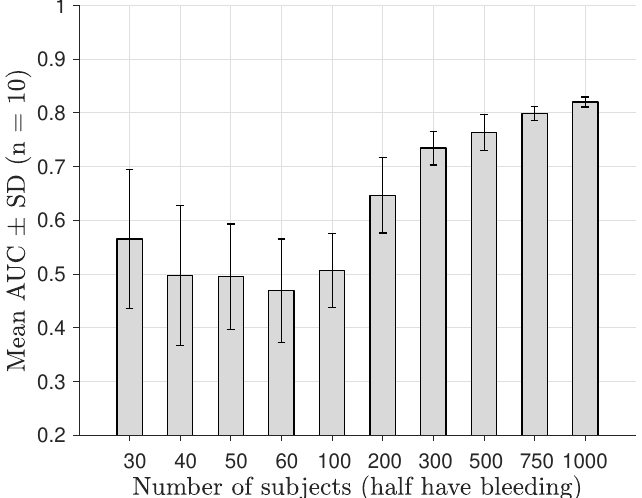
Figure 7. AUC as a function of the number of training data samples, for microwave scattering data with a low amplitude noise floor at − 100 dB.